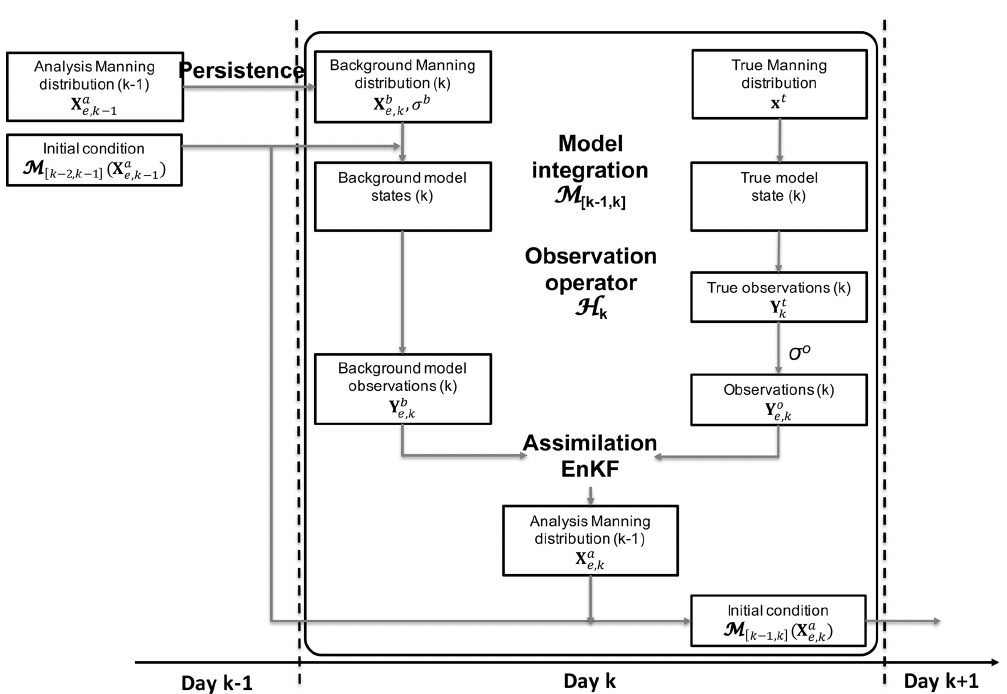
Figure 3. Data assimilation framework over the assimilation cycle [ k − 1 , k ] including (1) a forecast step to integrate the ensemble of ISBA-CTRIP simulations, each member having a different spatially distributed Manning coefficient, (2) and an analysis step to correct this ensemble of Manning coefficients using synthetic observations through the Kalman filter equation and re-run the ISBA-CTRIP model with these analysis estimates to obtain the updated model